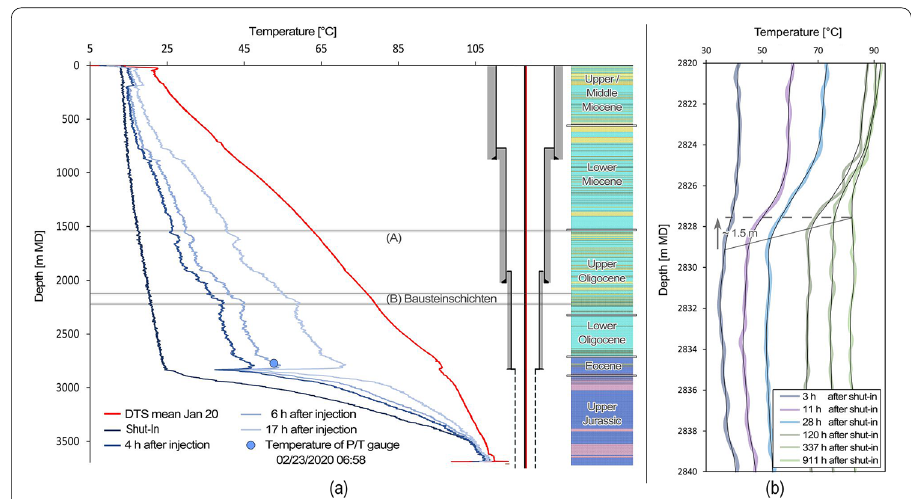
Fig. 10 DTS profiles during warm-back of Inj2. a Warm-back profiles at 4, 6 and 17 h after shut-in together with the mean profile of January 2020 and the Shut-In profile over whole borehole in comparison to stratigraphic units and the well completion. b DTS peaks during long-term warm-back at top of the reservoir from 2810 m MD to 2840 m MD. The bold curves are raw DTS data, fine black curves are moving average over 2 m. The gray line indicates a vertical shift of about 1.5